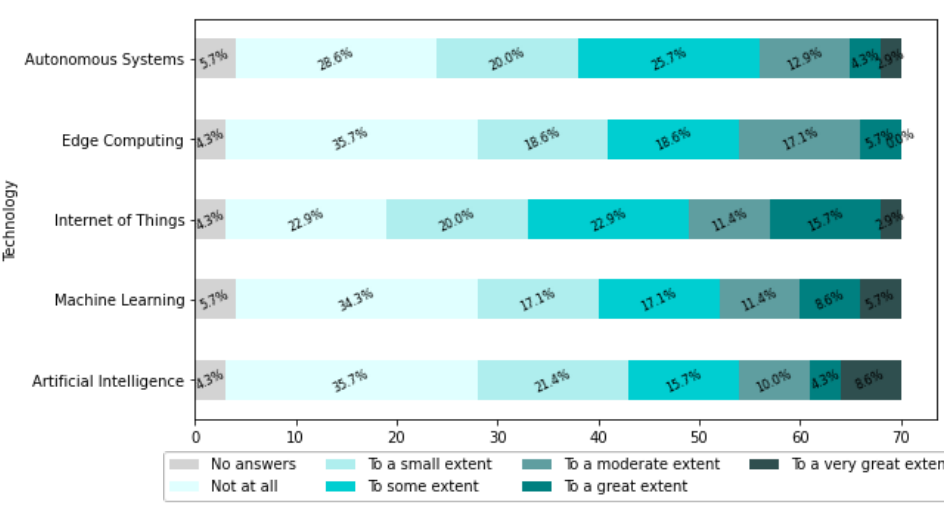
Figure 21. The extent to which the companies have practical skills in the presented technologies — number of questionnaires in a total number of 70